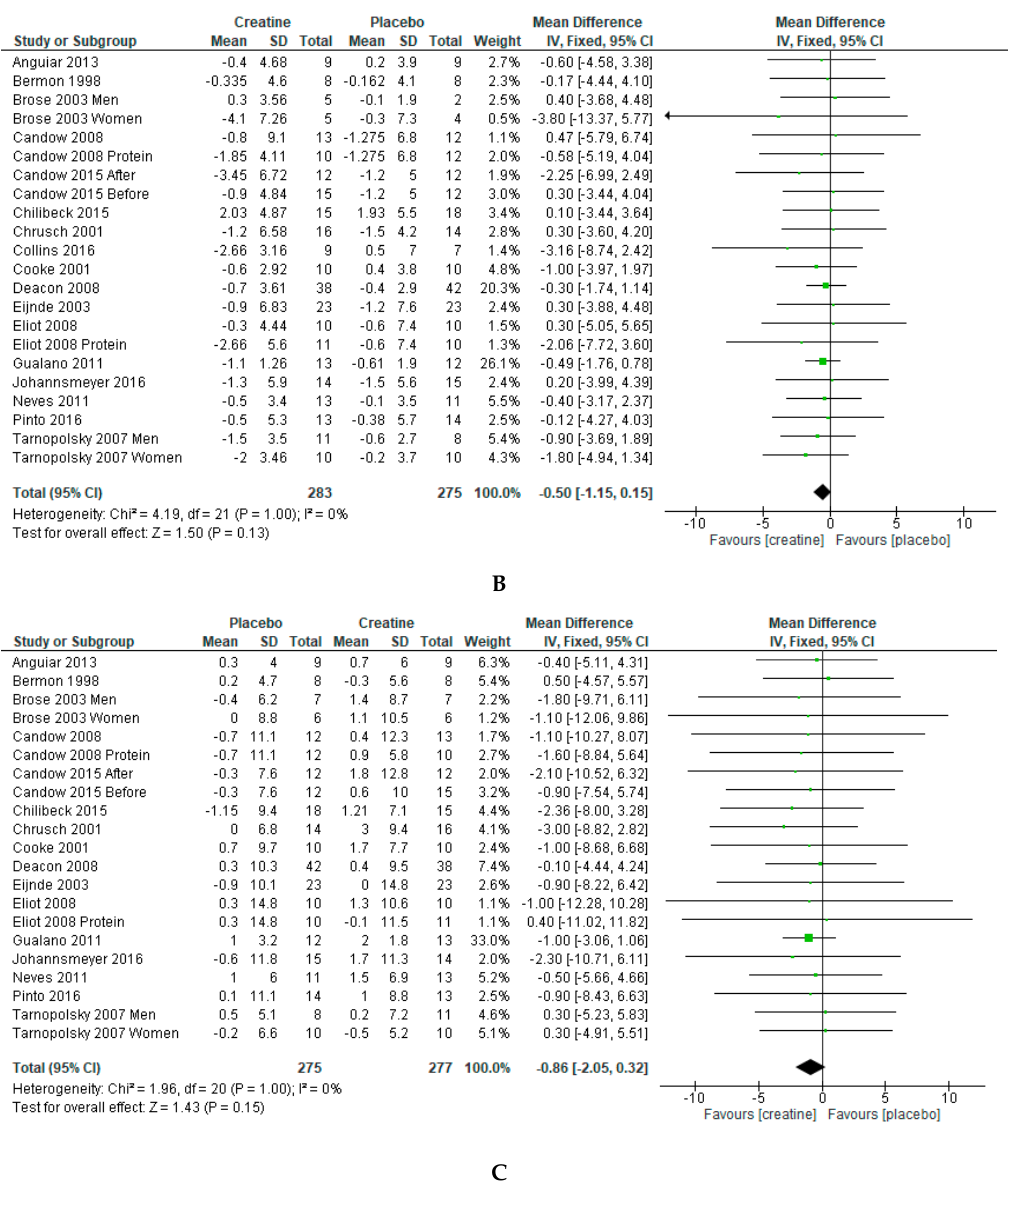
Figure 1. Forest plots for body fat percentage (%) ( A ), absolute fat mass (kg) ( B ) and body mass